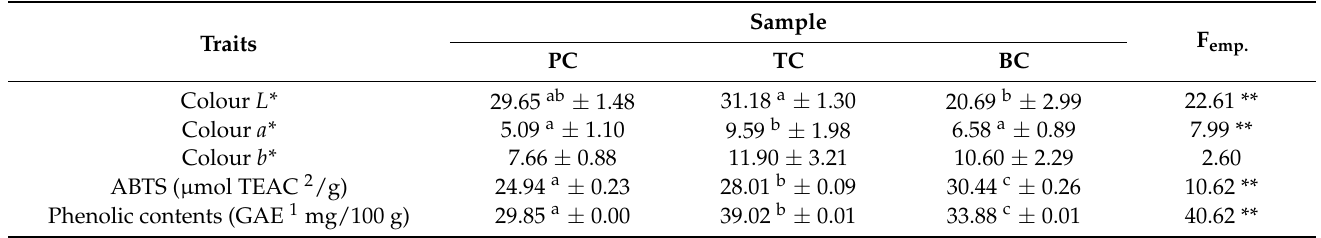
Table 2. The results of the colour parameters measurements ( n = 6) and the antioxidant activity (ABTS) and total phenolic contents (GAE) of cakes ( n =